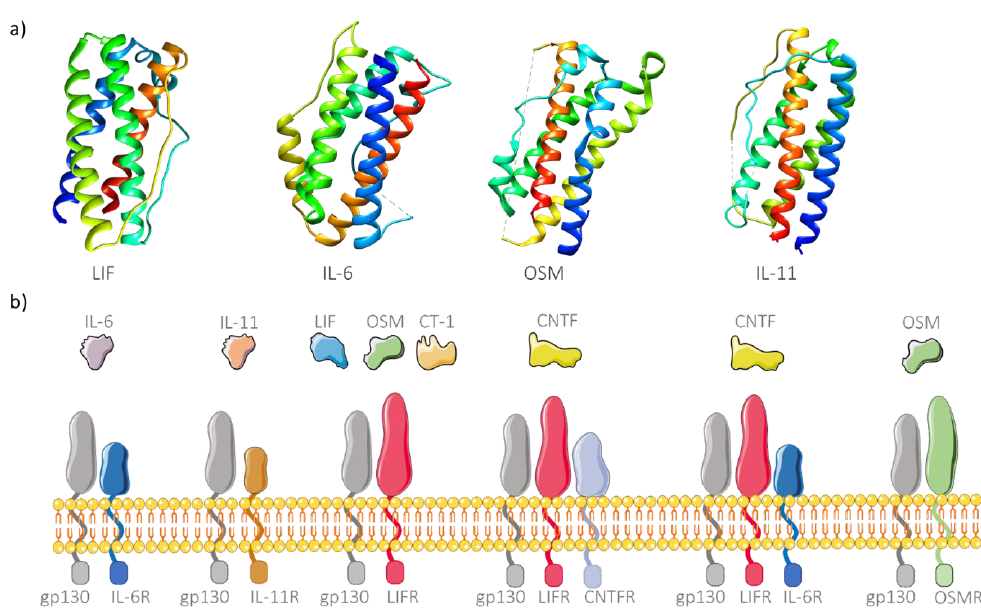
Figure 1. Structure and binding a ffi nity of IL-6 family members. ( a ) Three-dimensional structure of four members of IL-6 cytokine family: LIF (leukemia inhibitory factor; PDB ID 1emr), IL-6 (interleukin-6; PDB ID 1alu), OSM (oncostatin M; PDB ID 1evs) and IL-11 (PDB ID 4mhl), showing the characteristic top (helix A, blue), top (helix B, light blue to green), down (helix C, green to yellow), down (helix D, orange to red) helix arrangement. ( b ) Receptor complexes of IL-6 cytokine family. The signaling receptor subunit gp130 is shared by all family members. IL-6 and IL11 have their specific subunits (IL6R and IL-11R, respectively). OSM can bind to OSMR and gp130 but also to LIFR. In turn, LIF and CT-1 (cardiotrophin-1) transduce intracellular signaling through binding to gp130 and LIFR. A